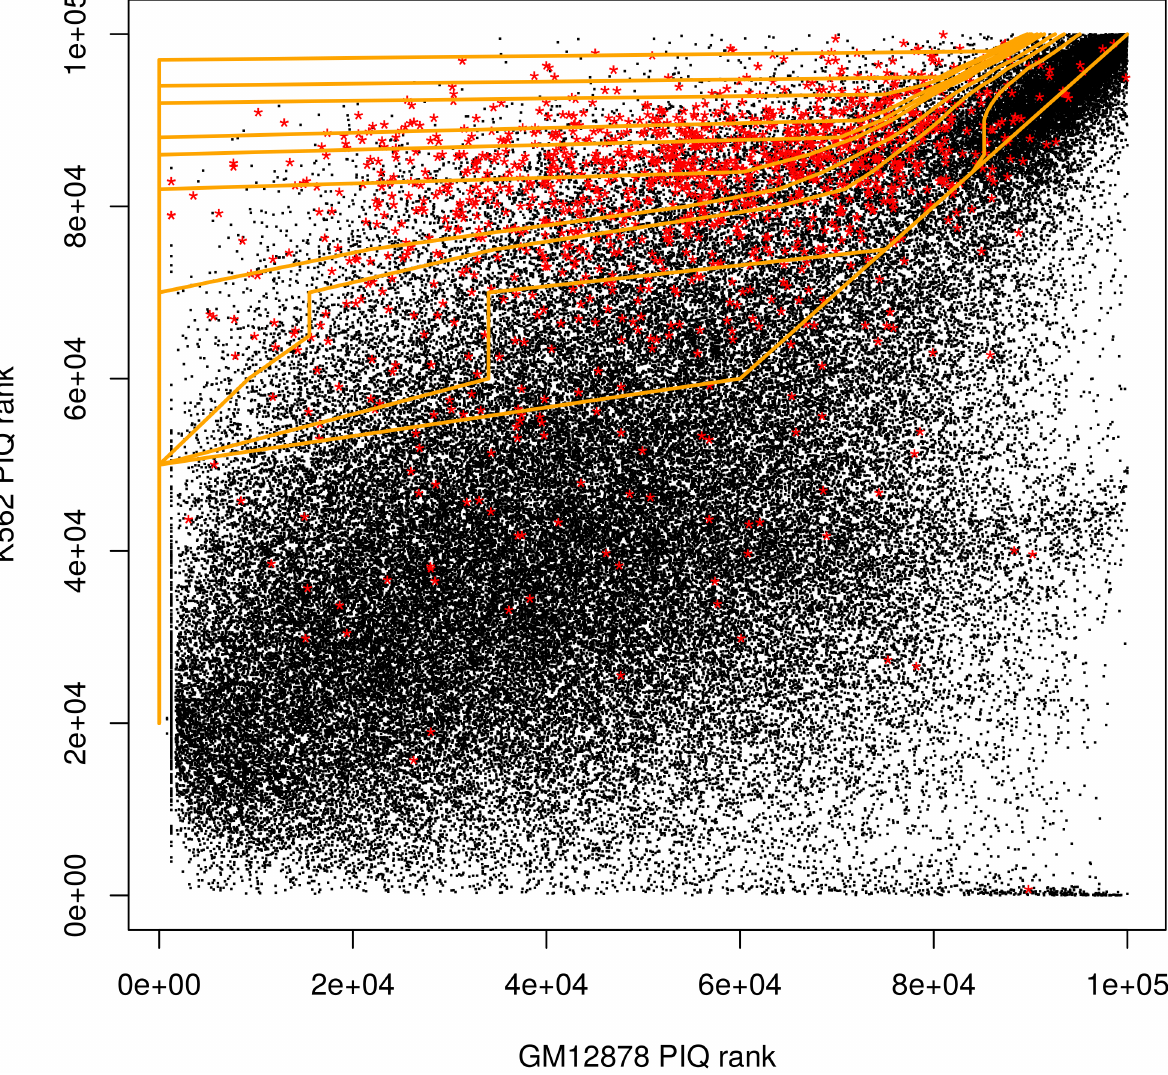
Fig 3. DeltaBind decision boundaries (orange) of different confidence levels. Axes are K562 PIQ rank vs. GM12878 PIQ rank. Red represents true differentialsites indicatedby ChIP-seq signals.